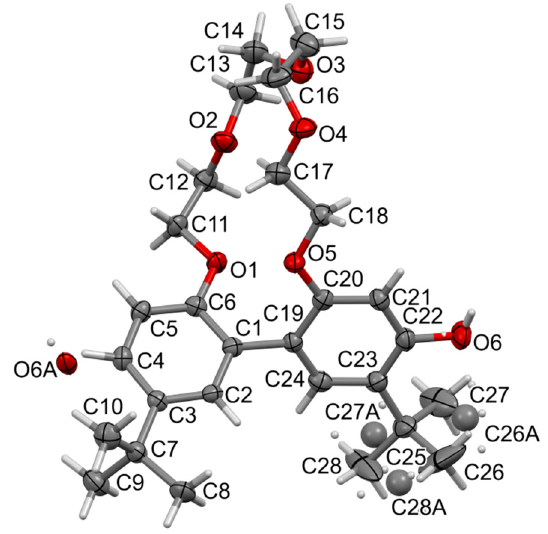
Figure 7. Molecular view of t -Bu-17- p -OH showing atom labelling scheme. Less populated disorder part atoms drawn as disconnected balls. Displacement ellipsoids drawn at 50% probability level. Selected bond lengths (Å) and angles (°): O6-C22 1.377(5), O1-C6 1.373(3), O1-C11 1.428(3), O2-C12 1.420(4), O2-C13 1.417(4), O3-C14 1.429(4), O3-C15 1.421(4), O5-C18 1.420(4), O5-C20